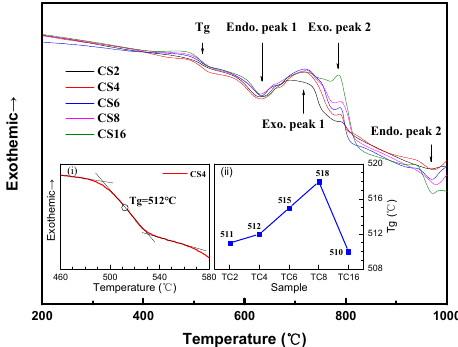
Figure 3. DSC curves of the TC composites with different TC contents at a heating rate of 10 °C/min (i) glass transition temperature of CS 4, (ii) Tg values of the TC composites with different TC contents.